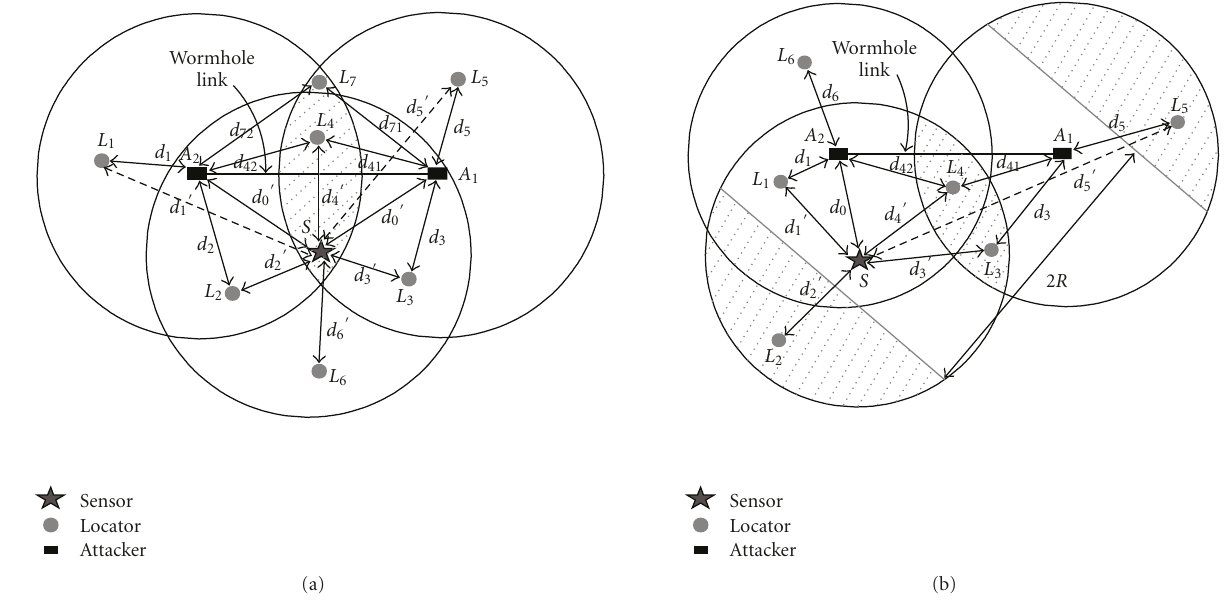
Figure 1: Illustrations of wormhole attack: (a) Duplex wormhole attack, (b) Simplex wormhole attack.